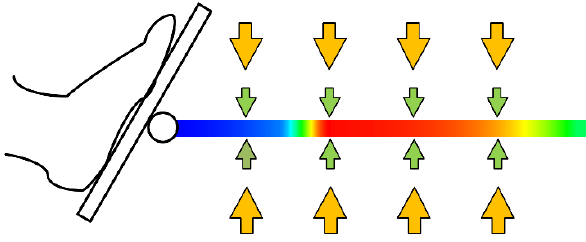
Figure 6. Working schematic diagram of admittance controller.